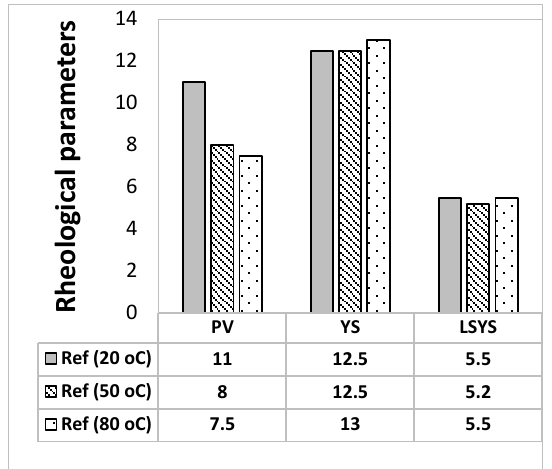
Figure 2. Reference MoS 2 -free drilling fluid.